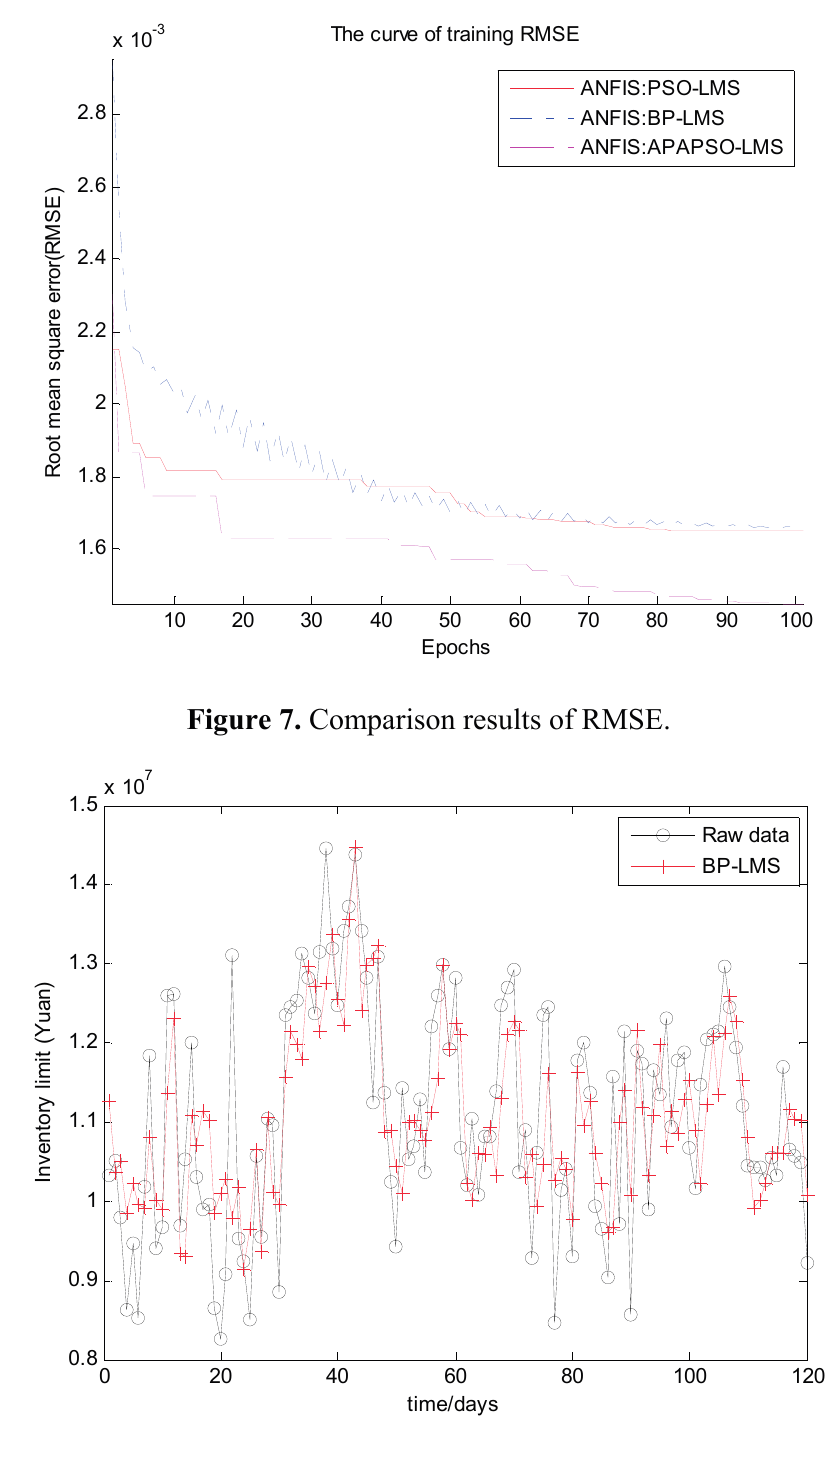
Figure 8. Prediction results based on BP-LMS